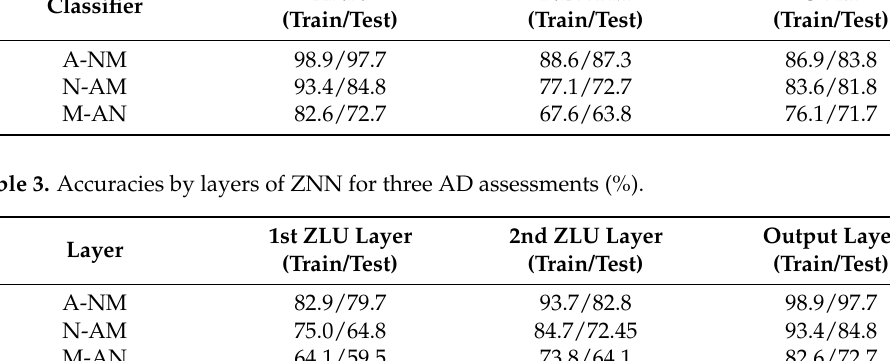
Table 4. 16 Selected discriminative ROIs for three AD assessments.